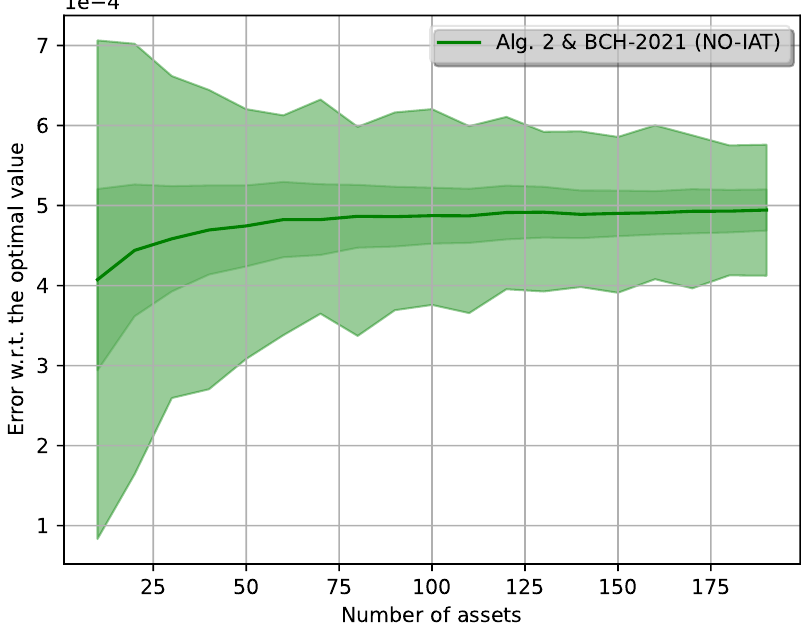
Figure 3. Graph of the error of Algorithm 2 and BCH-21 with respect to the number of assets in the market. The center lines represent the average on 1000 thousand tests. The inner shaded area represents the standard deviation around the average. The borders of the outer shaded area represent the maximum and minimum